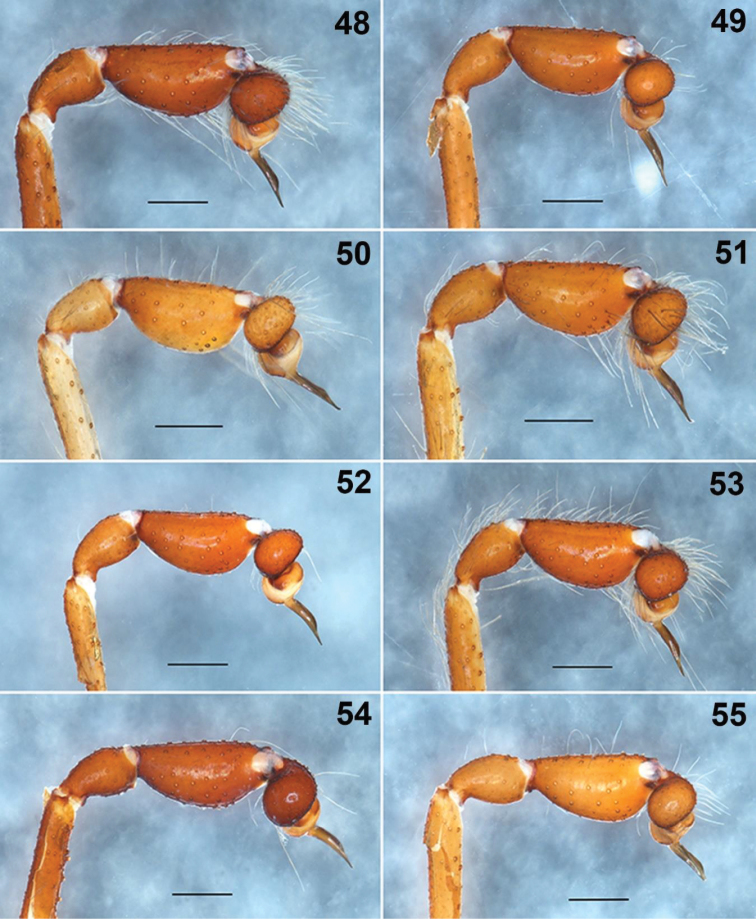
Loxosceles
tenochtitlan sp. nov. Variation of the male palps, left palps, prolateral views 48 turiello Guerra, Street Cuitlahuac S/N, Tlalpan, Mexico City 49 Cruz Verde #132, Tlalpan, Mexico City (type locality) 50 Street Tepocatl #61, Pedregal de Santo Domingo, Coyoacán, Mexico City 51 Los Reyes Copilco, Frac. Areada Dpto. 102-A, Coyoacán, Mexico City 52, 53 Street Reforma #5, Santiago Tlacochcalco, Municipality of Tepeyanco, Tlaxcala 54, 55 Street Juárez Norte #214, Huamantla, Municipality Huamantla, Tlaxcala, Mexico. Scale bars: 0.5 mm.